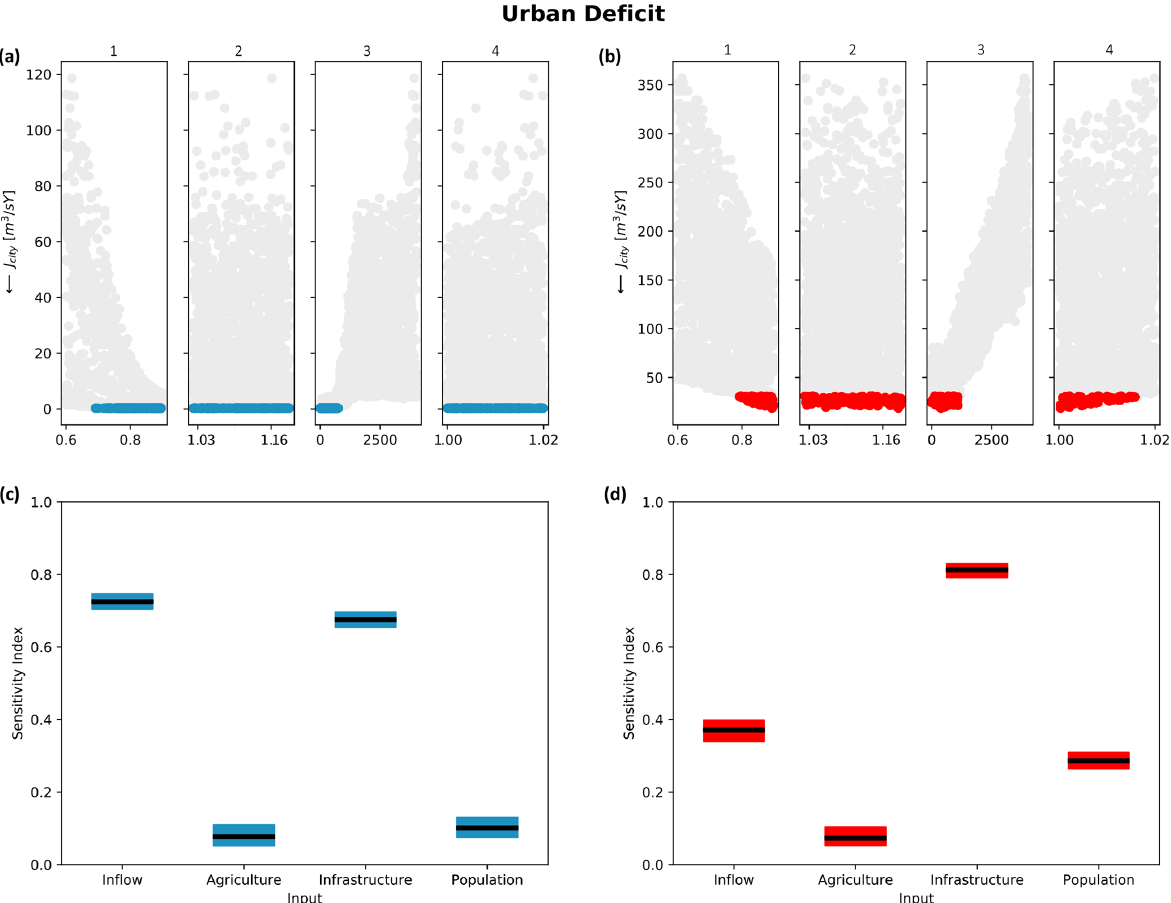
Figure 8. Behavioral perturbations (a, b) and sensitivity index (c, d) for the robust urban deficit (blue) and non-robust (red)